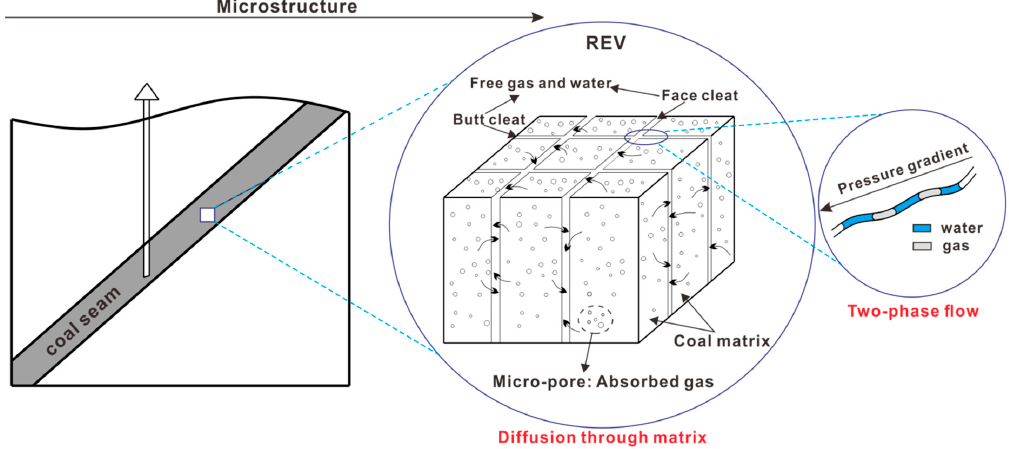
Figure 2. Methane and water migration mechanisms in a steeply-dipping coal